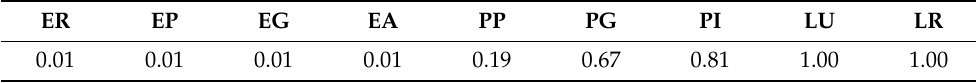
Table 4. Neighborhood factor values for different PLE subclasses.